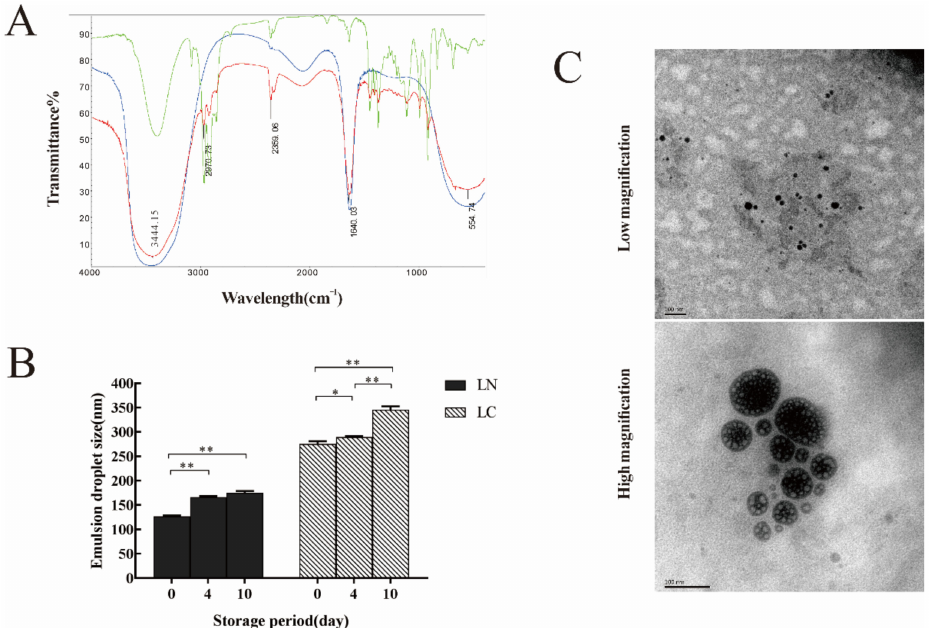
Figure 2. Physicochemical properties of LN. ( A ) Infrared spectra of the Linalool, aqueous phase, and LN by FTIR. Red curve: LN; blue curve: aqueous phase; green curve: Linalool. ( B ) The diameters of LN and LC (nm) were measured after 0, 4, and 10 d of storage. * and ** represented p < 0.05 and p < 0.01, respectively. ( C ) The TEM observation of the morphology and emulsion droplet size